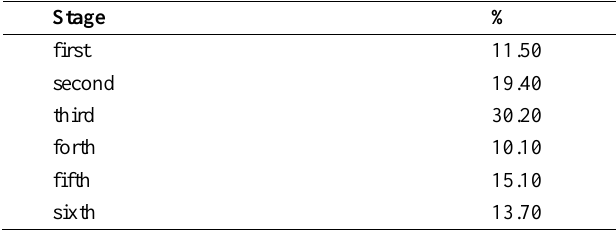
Table 1: Study population distribution